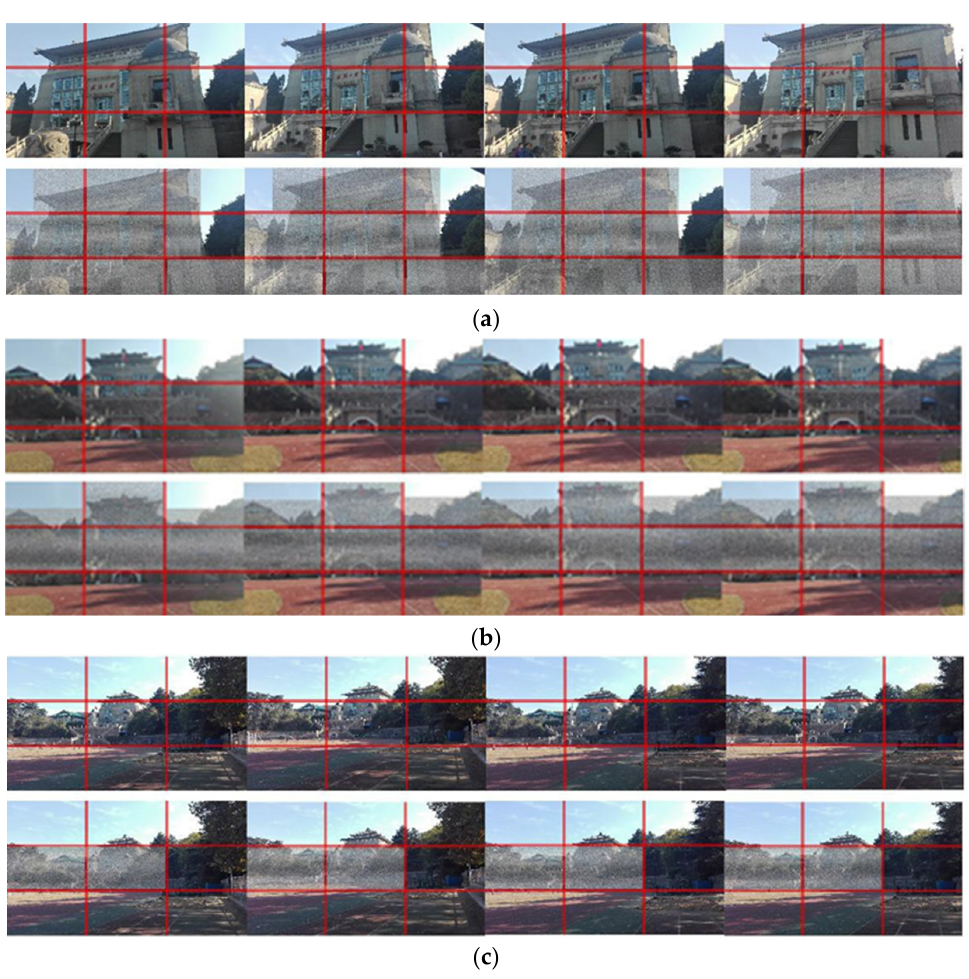
Figure 3. The fixed-point photography experiment. ( a ) Composition analysis of close-up photographs; ( b ) composition analysis of mid-range photographs; ( c ) composition analysis of long-range photographs.